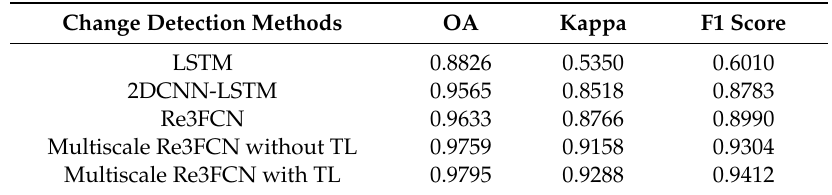
Figure 6. Change detection maps obtained from the proposed method and other methods for site 2 including (a) ground truth map (b) LSTM, (c) 2D CNN-LSTM, (d) Re3FCN, (e) the proposed method without transfer learning, and (f) the proposed method with transfer learning. Ω 𝑐 and Ω 𝑢 represent changed and unchanged classes, respectively. Table 4. Comparison of results of evaluation parameters for different change detection methods for Site 2.